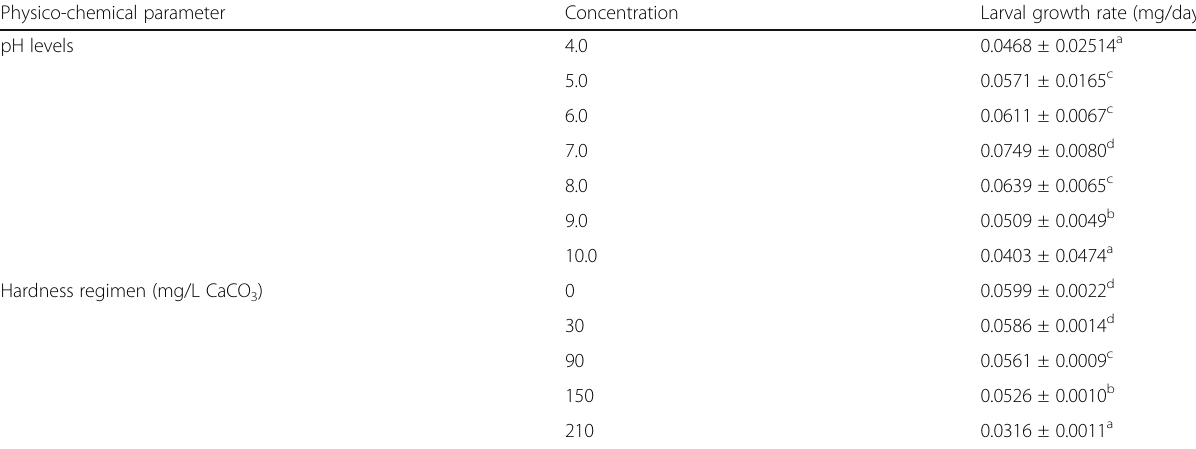
Table 2 Effects of water pH and hardness levels on growth rate of Culex quinquefasciatus Physico-chemical